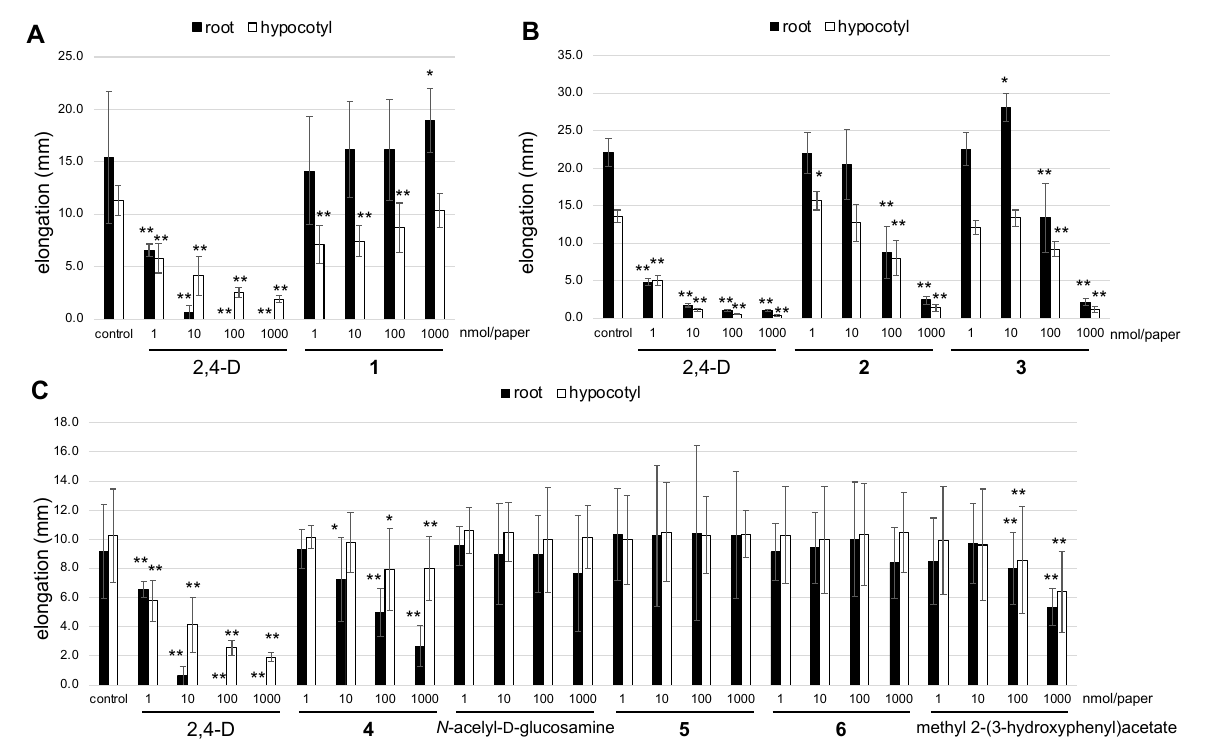
Figure 5. Effect of 1 to 6 , N -acelyl- D -glucosamine and methyl 2-(3-hydroxyphenyl)acetate on the growth of lettuce. ( A ). compound 1 ; ( B ). compounds 2 and 3 ; ( C ). compounds 4 – 6 and their analog compounds. Lettuce seedlings were treated with compounds. Respective length of growth compared with the control ± standard deviation (* p < 0.05, ** p < 0.01 vs. control, n = 9).